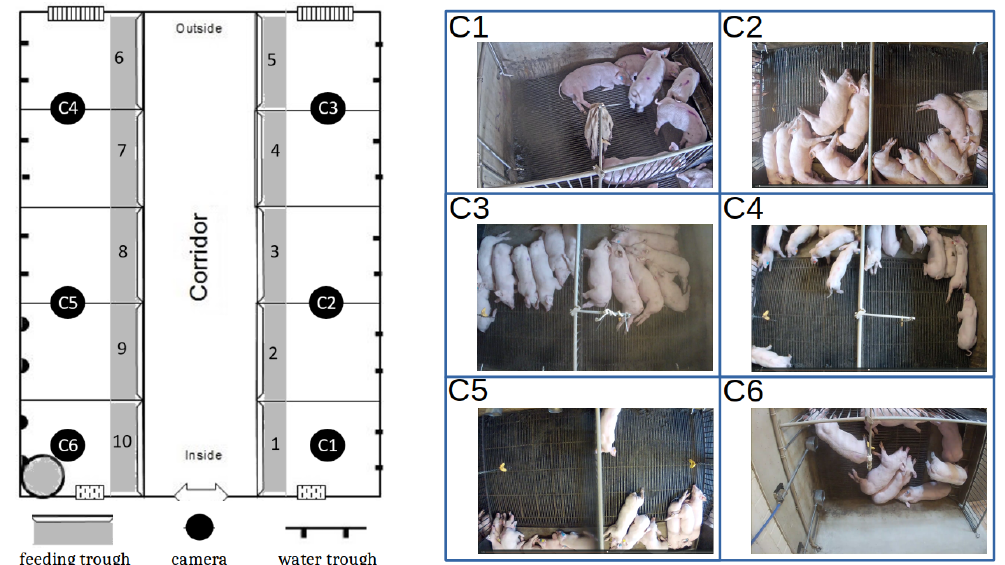
Figure 2. The data set consists of video recordings from six cameras and ten pens of pigs, with camera 1 (C1) and camera 6 (C6) recording a single box with six and seven piglets, respectively, and the remaining cameras (C2–C5) recorded two pens with seven piglets each. The left side shows the camera arrangement within the pig